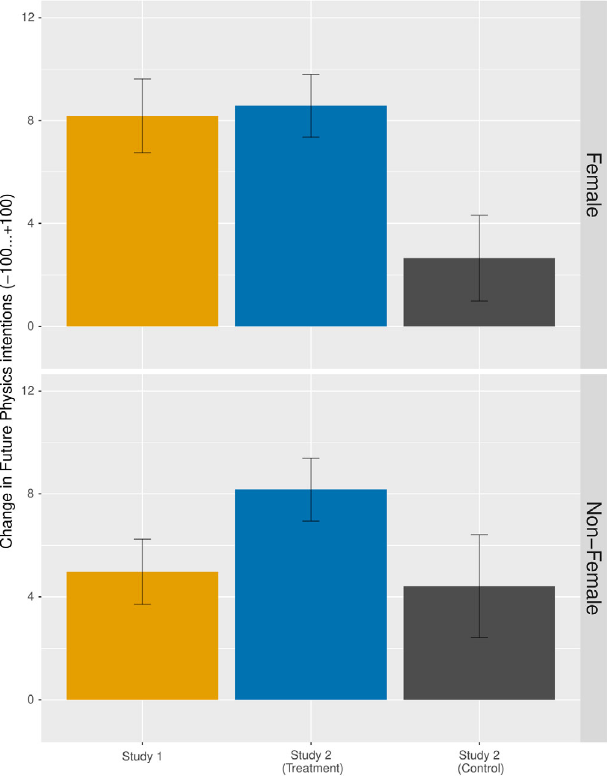
FIG. 1. Outcome of Study 1 (yellow-orange) and Study 2 (treatment in blue, control in gray). Female-identified students (top panel) show statistically significant gains in future physics intentions in Study 1 and Study 2 treatment. Non-female- identified students (bottom panel) show gains in Study 1, Study 2 treatment, and Study 2 control. The difference between treat- ment and control is statistically significant for female students ( p ¼ 0 . 005 ); it is not statistically significantly different for nonfemale students ( p ¼ 0 . 11 ). The height of each bar is pre- post change in physics intentions (scale − 100 to þ 100 ); error bars represent standard errors.